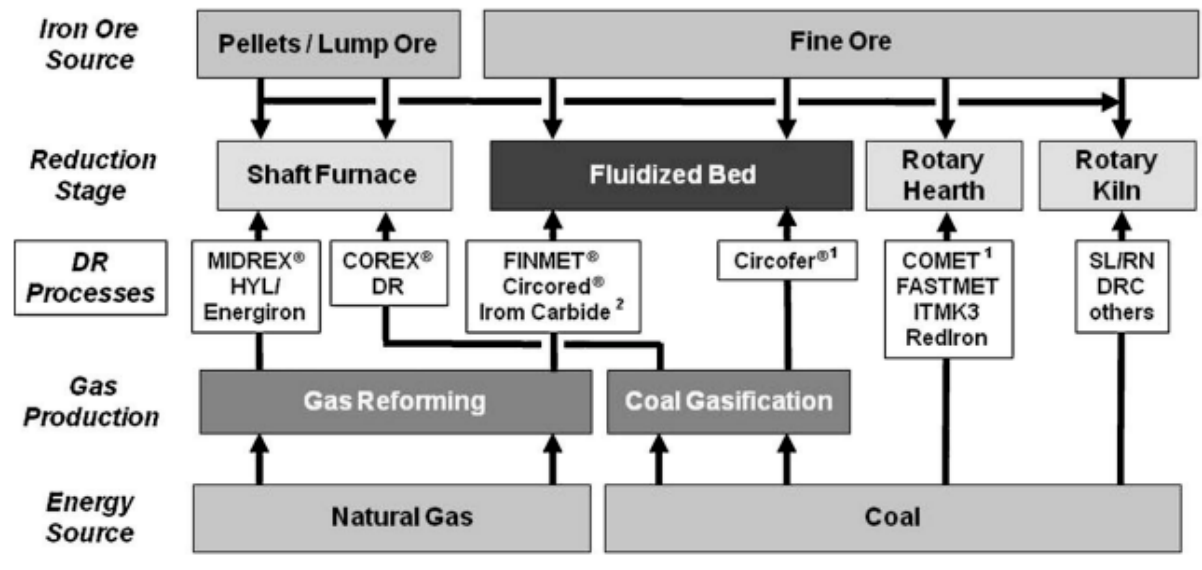
Figure 1. Classification of direct reduction processes [5].